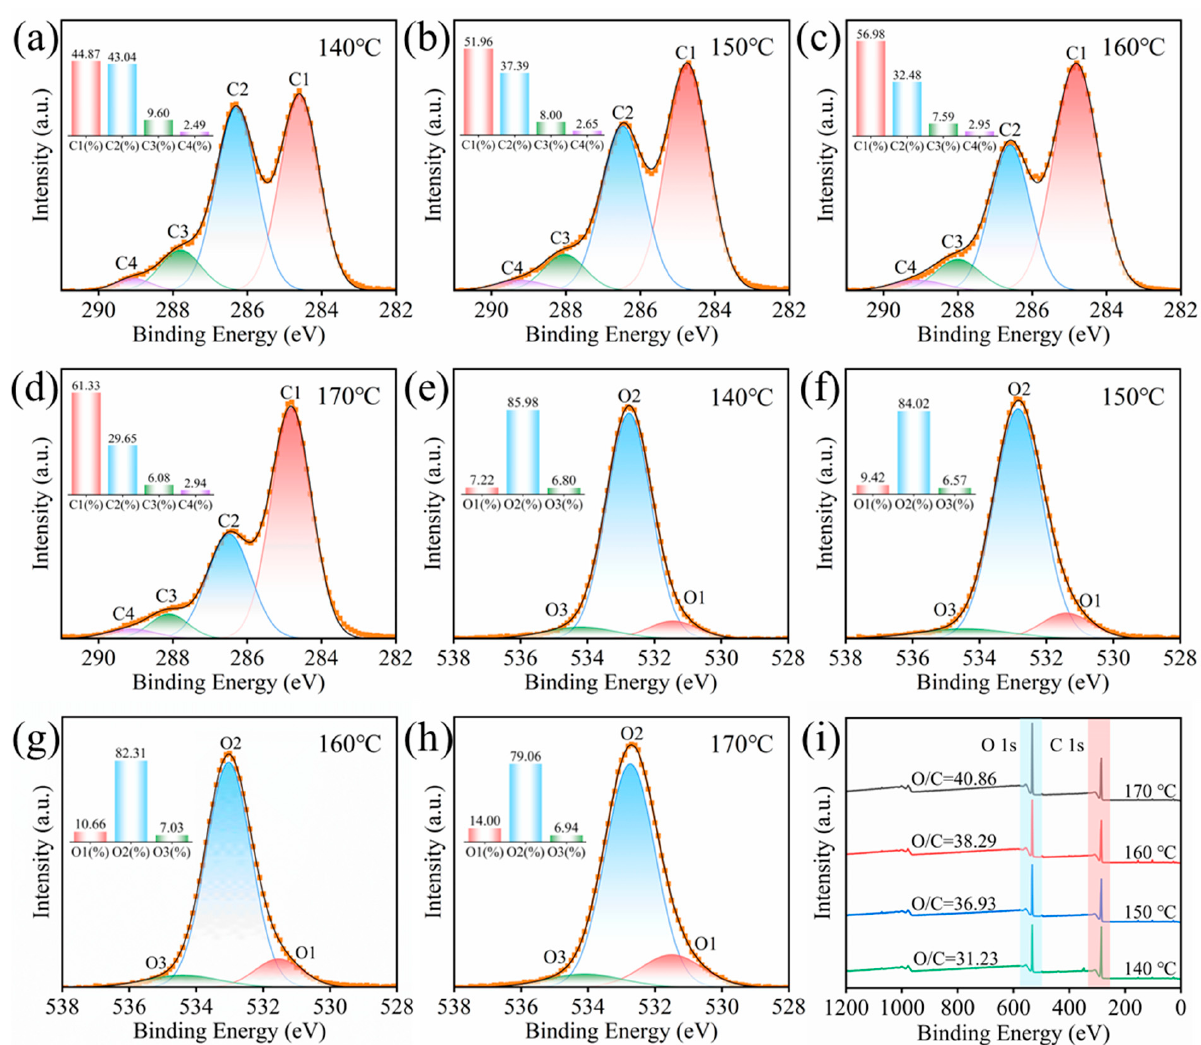
Figure 8. XPS spectra of bamboo scrimber at different hot-pressing temperatures: ( a ) C 1s-140 ◦ C, ( b ) C 1s-150 ◦ C, ( c ) C 1s-160 ◦ C, ( d ) C 1s-170 ◦ C, ( e ) O 1s-140 ◦ C, ( f ) O 1s-150 ◦ C, ( g ) O 1s-160 ◦ C, ( h ) O 1s-170 ◦ C; ( i ) XPS spectra of bamboo scrimber at hot-pressing temperatures of 140 ◦ C, 150 ◦ C, 160 ◦ C, and 170 ◦ C.